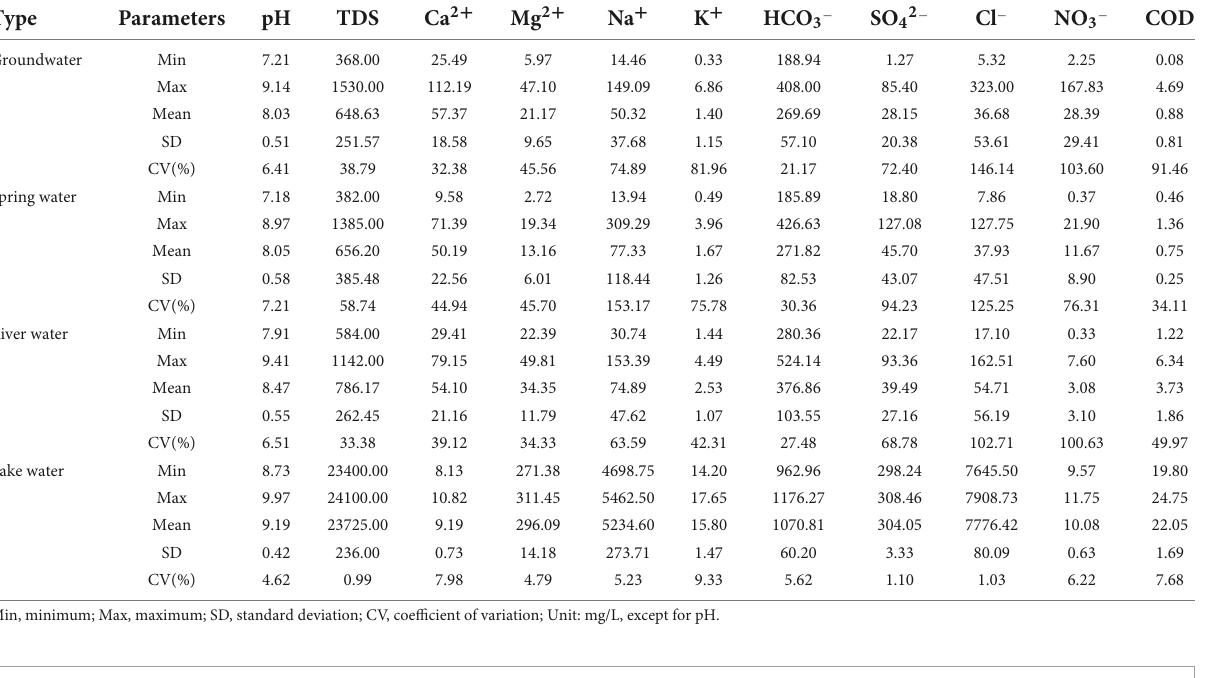
TABLE 1 Statistics of main chemical parameters of water in the Daihai Lake Basin.